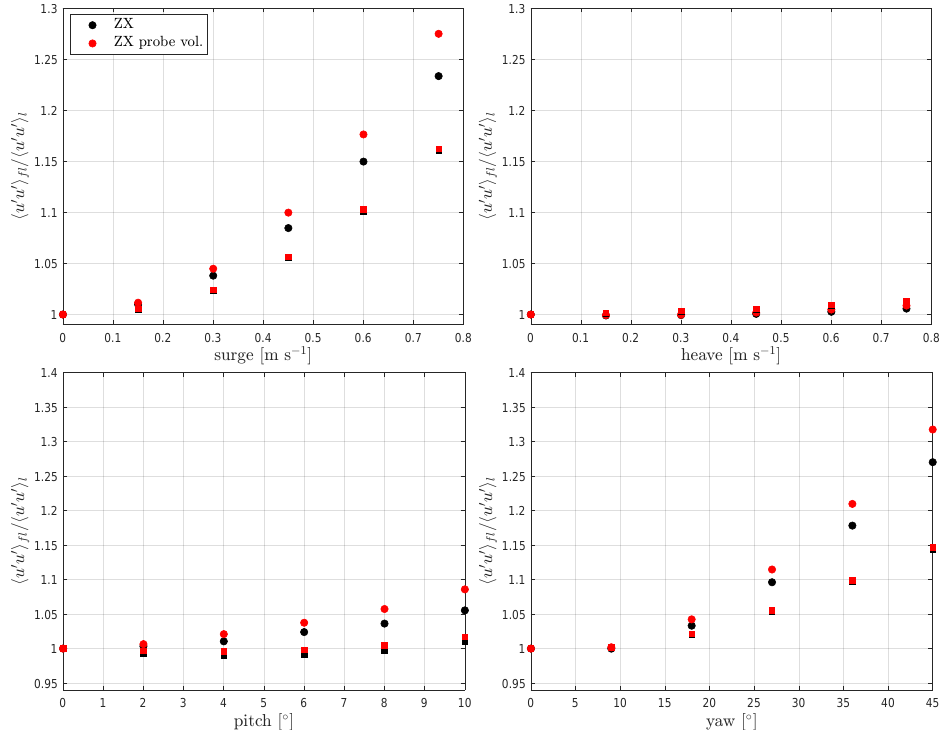
Figure 6. Ratio of the u -velocity (along-wind) variance measured by a VAD floating ZX lidar (subscript fl ) to that measured by a VAD fixed ZX lidar (subscript l ) as function of the amplitude of the motion (surge in top-left, heave in top-right, pitch in bottom-left, and yaw in bottom-right frame). Results with and without probe volume are shown (see legend). Square and circle markers correspond to a height of 30 and 100 m, respectively. Results correspond to the means of 20 turbulence boxes. The period of the motion is 4